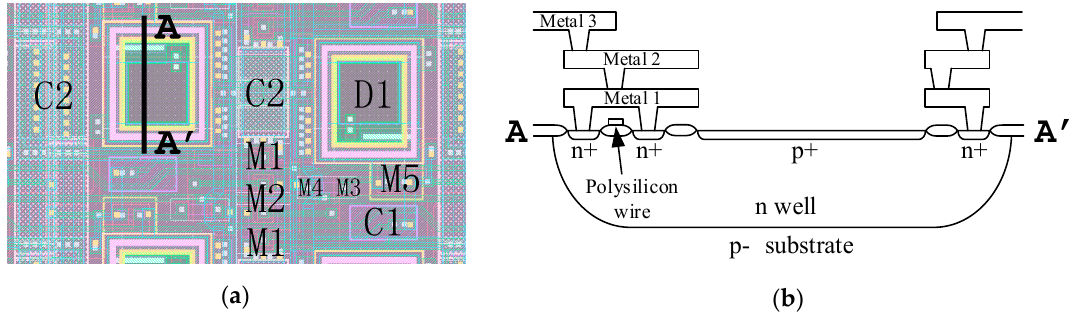
Figure 3. ( a ) The layout of two pixels; ( b ) Cross-sectional diagram of the p+/n-well photodiode in a pixel.